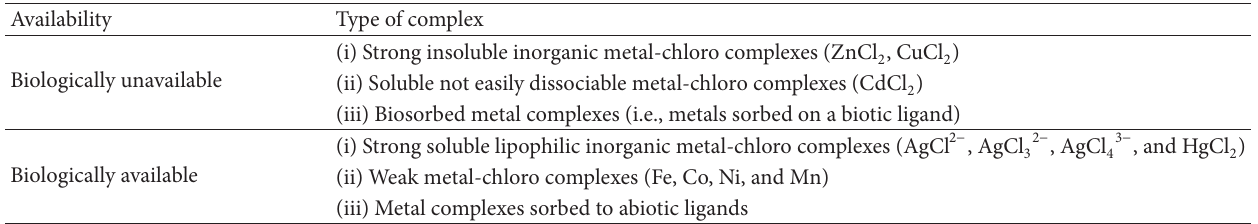
Table 2: Bioavailability of metal-ligand complexes in hypersaline conditions depending upon the nature of the complex formed. Availability Type of complex Biologically